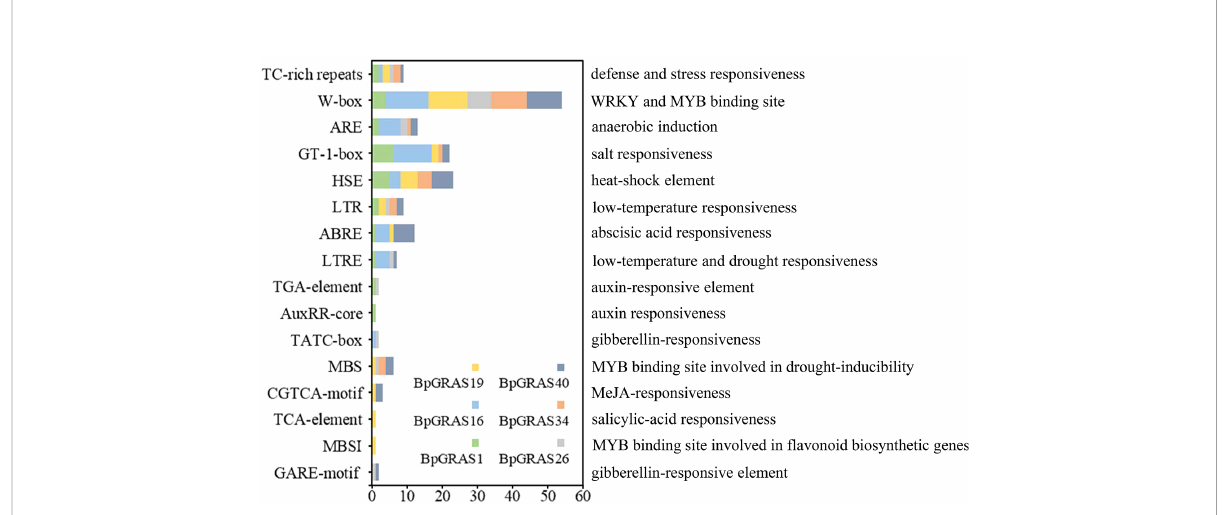
FIGURE 6 The cis-acting elements of 6 GRAS gene promoters in birch related to environmental stress and phytohormone signals. The X-axis indicates the number of each of the cis-acting elements; the Y-axis indicates the different cis-acting